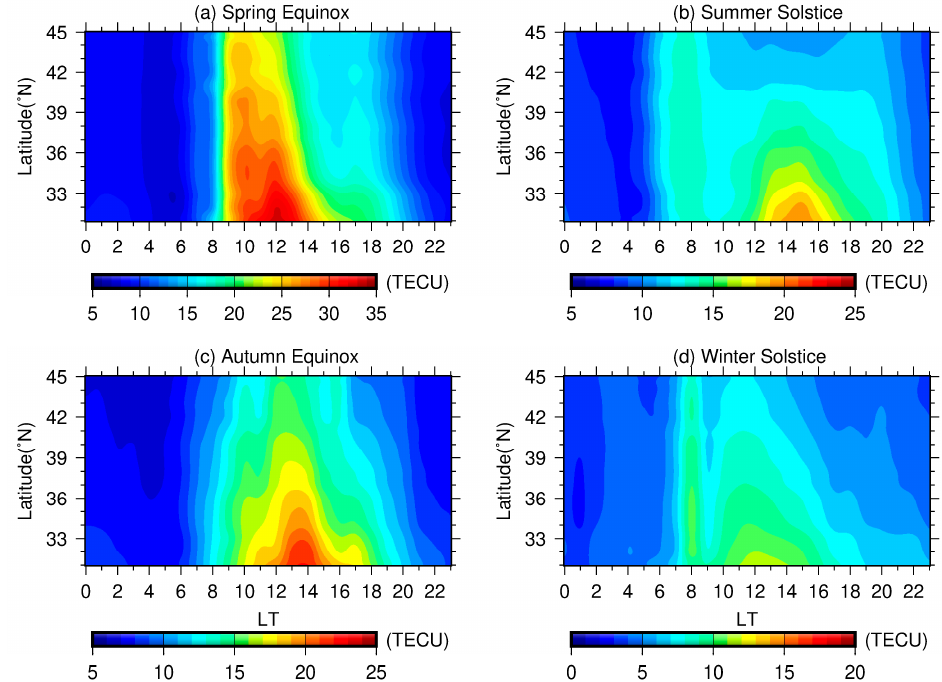
Figure 5. Latitudinal variation of hourly JIM-TEC over Japan during the spring equinox, summer solstice, autumn equinox and winter solstice of 2016 (local time, LT).